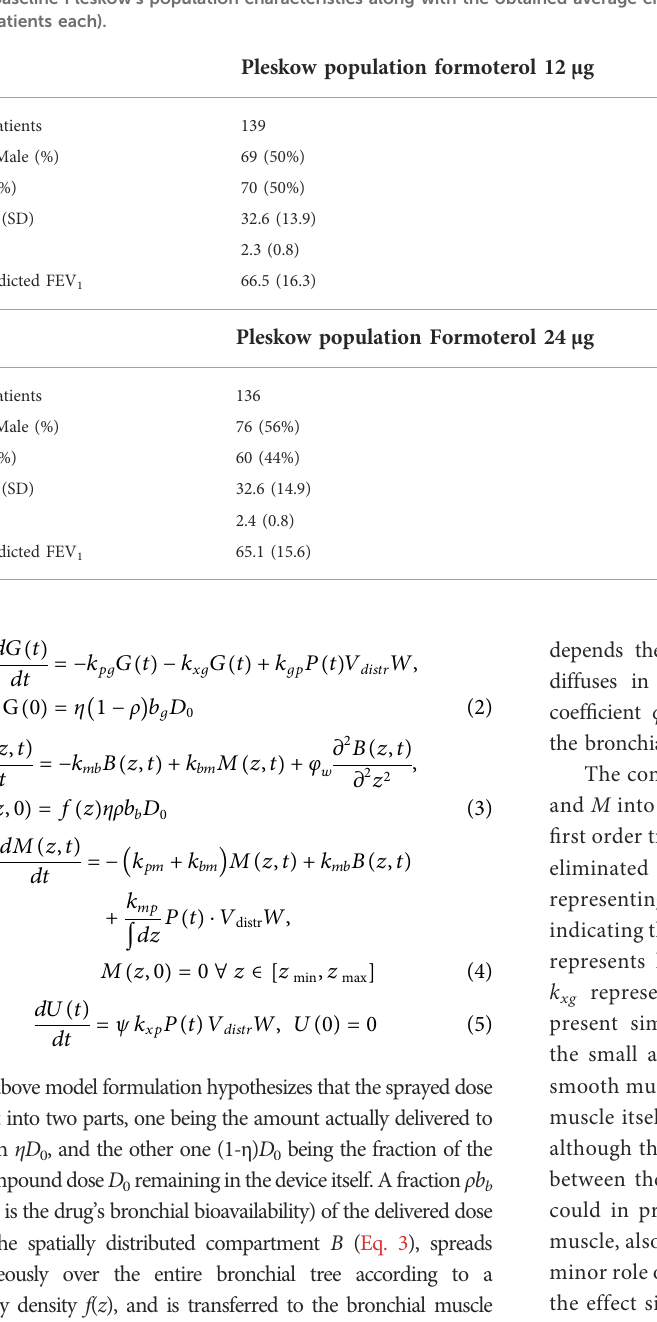
TABLE 1 Baseline Pleskow ’ s population characteristics along with the obtained average characteristics from the two simulated populations (10,000 patients